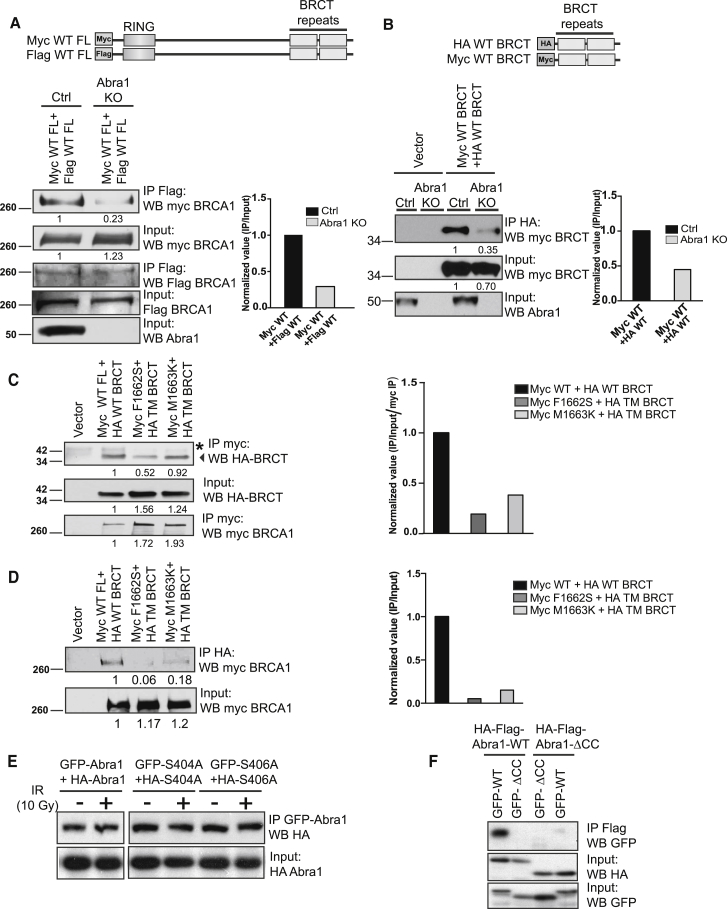
Abraxas Promotes BRCA1 BRCT Dimerization In Vivo(A) Abraxas-dependent BRCA1 dimerization in vivo. The differentially Myc- and FLAG-tagged BRCA1 full-length constructs were transiently transfected into parental 293T (Ctrl) or Abraxas KO cells. The lysates from cells treated with 10 Gy IR followed by 1 hr incubation at 37°C were used for FLAG-immunoprecipitation. The intensity of individual bands was quantified by densitometric analysis using NIH ImageJ software. The normalized value (IPed_mycBRCA1/Input_mycBRCA1) was shown in the bar graph.(B) Abraxas-dependent BRCA1-BRCT domains dimerization in vivo. The differentially Myc- and HA-tagged BRCA1-BRCT domains constructs were transiently transfected into parental 293T (Ctrl) or Abraxas KO cells. The lysates from cells treated with 10 Gy IR followed by 1 hr incubation at 37°C were used for HA-immunoprecipitation. The band intensity was quantified with NIH imageJ software. The normalized value (IPed_mycBRCT/Input_mycBRCT) was shown in the bar graph.(C and D) BRCA1 germline mutations F1662S or M1663K decrease BRCA1 dimerization in vivo. Myc-tagged BRCA1 full-length (WT-FL) and HA-tagged BRCA1 BRCT (WT-BRCT) or Myc-tagged mutant full-length (F1662S or M1663K) and HA-tagged BRCT triple mutant (TM, F1662S/M1663K/R1670E) were co-expressed in cells. The lysates from cells treated with 10 Gy IR followed by 1 hr incubation at 37°C were prepared for either Myc- immunoprecipitation (C) or reciprocal IP with HA- immunoprecipitation (D). The normalized value was shown in the bar graph.(E) Abraxas dimerize/oligomerize in vivo independent of binding to BRCA1. The differentially tagged GFP- and HA-FLAG-tagged WT or GFP-tagged and HA-FLAG-tagged Abra1 mutants (S404A or S406A) were co-expressed in cells. The anti-GFP immunoprecipitation was carried out with lysates from 293T cells treated or not treated with 10 Gy IR followed by 1 hr incubation at 37°C. The images are from the same blot.(F) Abraxas dimerizes/oligomerizes, in vivo, through the CC domain. The immunoprecipitations were carried out with lysates prepared from cells co-expressing HA-FLAG-tagged WT Abra1 or HA-FLAG-tagged CC domain deletion mutant (ΔCC) and GFP-tagged WT or ΔCC (see also Figure S6).